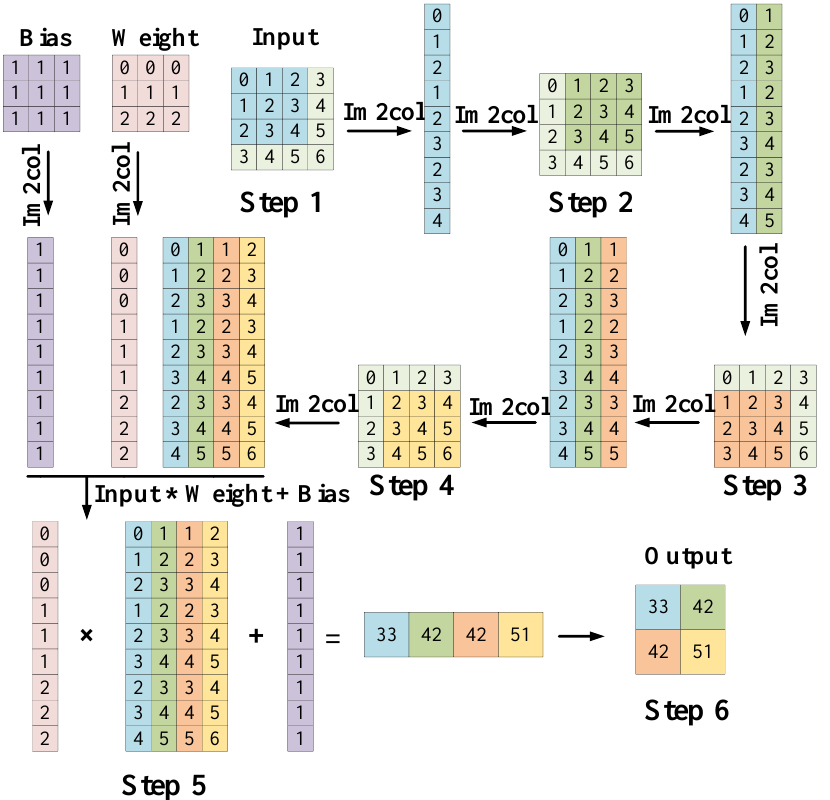
Figure 8. An example of the Im2col convolution optimization algorithm.